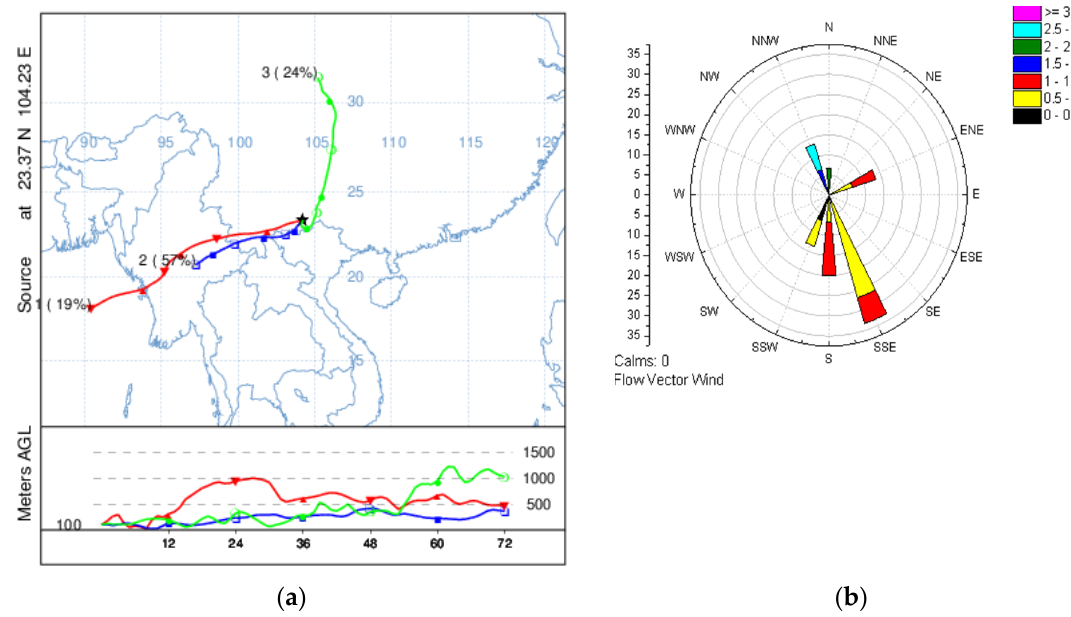
Figure 6. ( a ) Mean 72 h backward trajectories of each trajectory cluster during spring and the percentage of allocation to each cluster. ( b ) Wind roses of Wenshan during spring sampling.